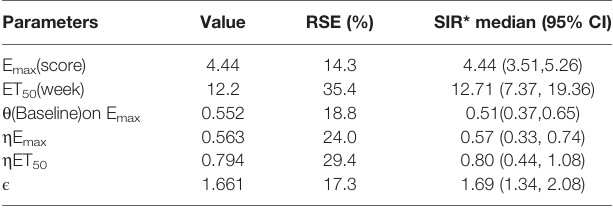
TABLE 2 | Parameter estimation of the fi nal model.